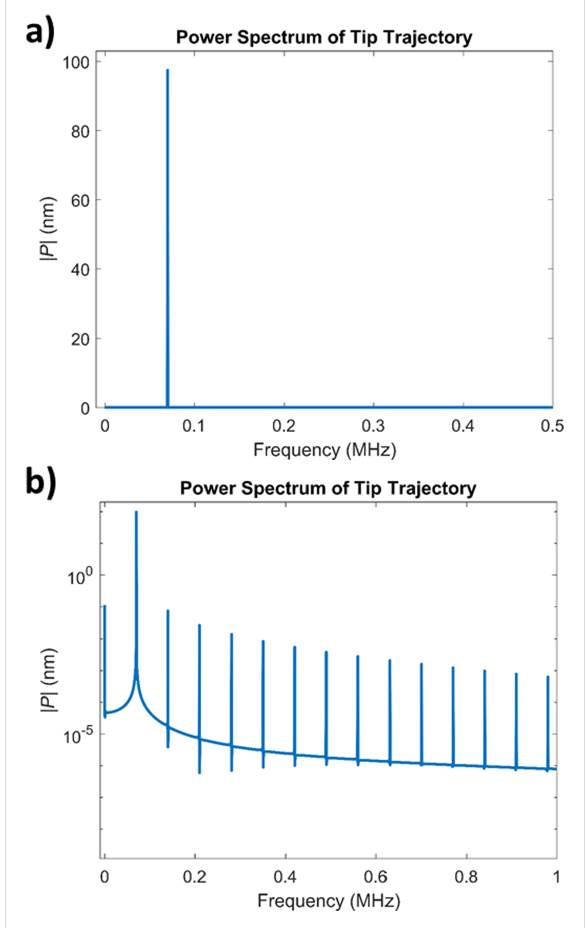
Figure 6: a) Power spectrum of the cantilever trajectory. The higher harmonic amplitudes are very small compared to the first harmonic amplitude, and their peaks are not visible in the spectrum with linear vertical axis. However, they are ever present and can be seen in a logarithmic plot (b), where the second harmonic is almost 1000 times smaller than the first